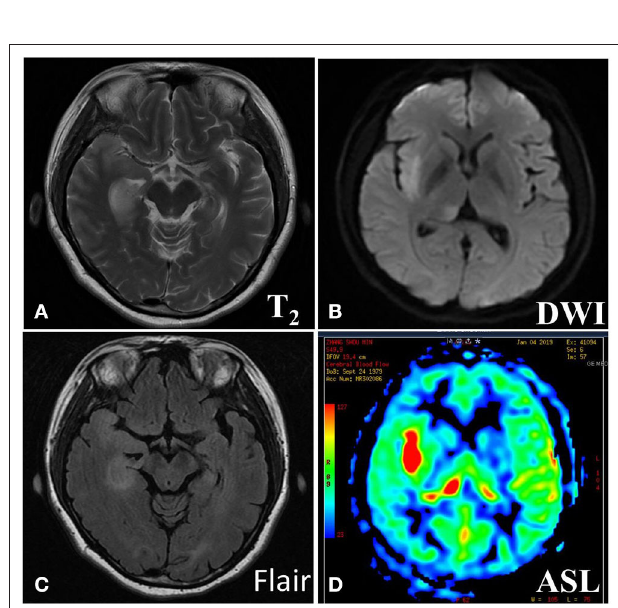
FIGURE 2 | Brain MRI (A) showed abnormal signal in right temporal and insular lobe, thalamus. On T2WI (B) and T2Flair (C) sequences, the right temporal and insular lobe, right thalamus showed slightly higher abnormal signal, the local cortex was slightly swollen, and on the DWI sequences, slightly higher signal was seen. On T2Flair sequence (C) , there was high abnormal signal in the right hippocampus and no obvious abnormal signal in the left hippocampus. Arterial spin labeling (ASL) sequence (D) showed significant hyperperfusion in the right temporal and insular lobe, thalamus.